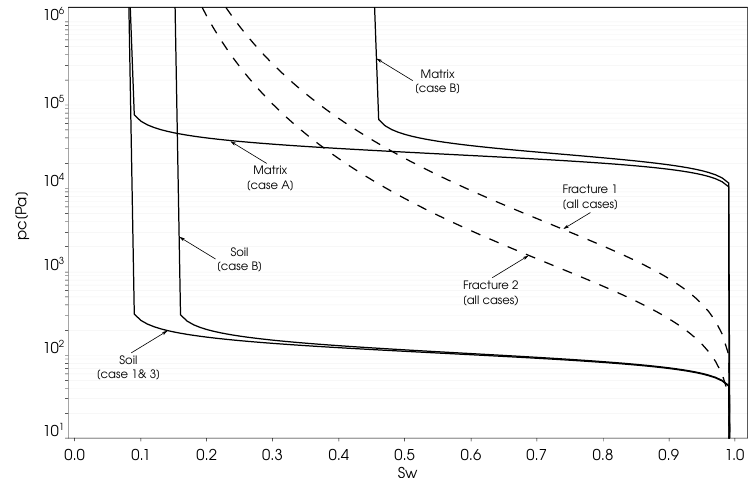
Figure 8. Capillary pressure curves of matrix and fracture of model TUFF2D.